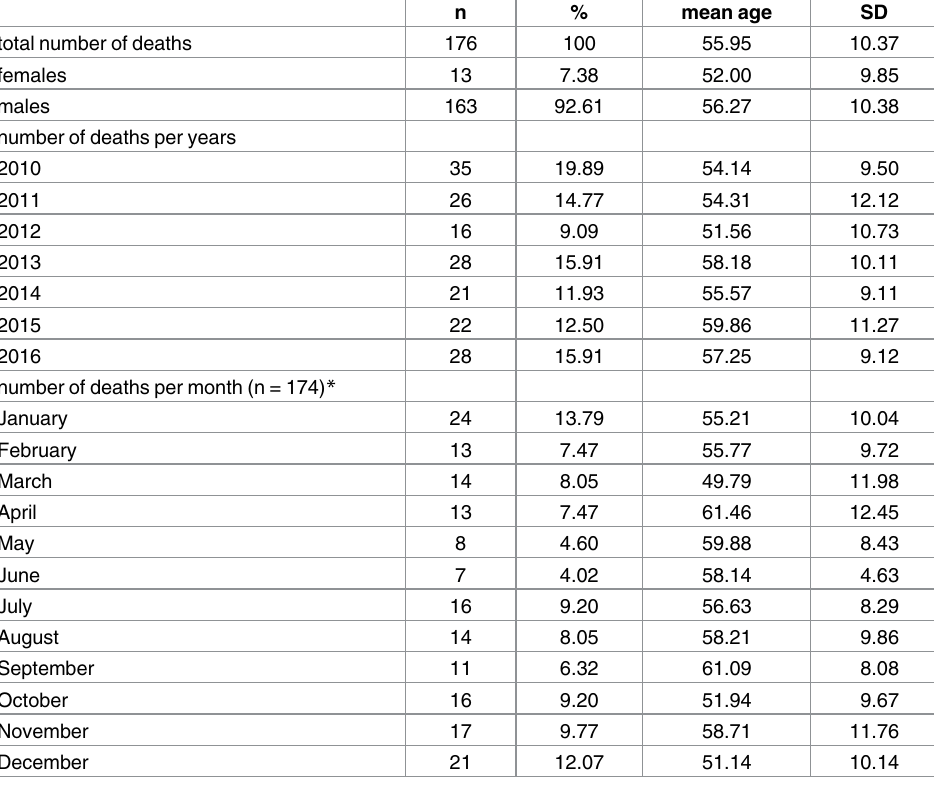
Table 1. Demographic data of the